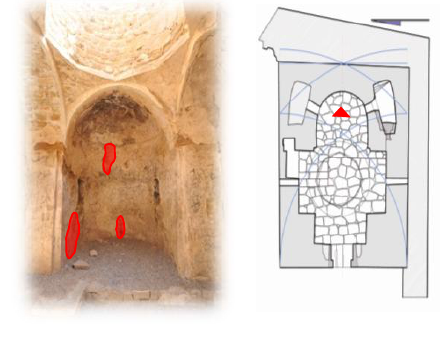
Figure 18. Mankind disaster